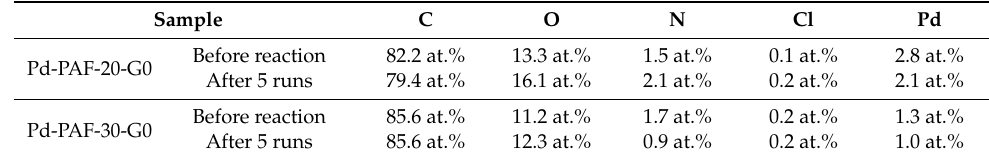
Table 9. Components of the XPS spectra after five runs of the recycle